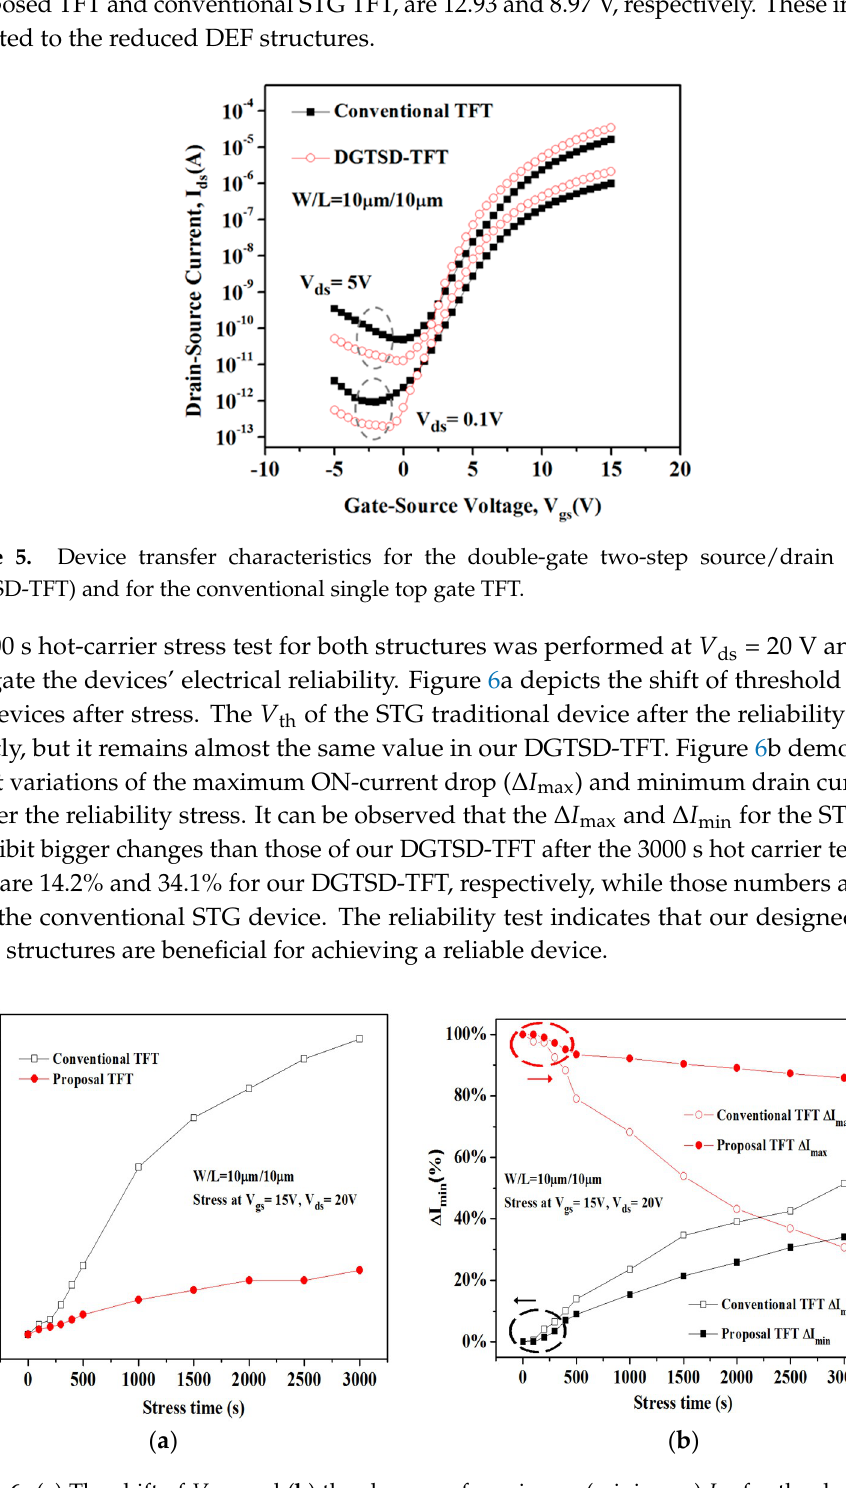
Figure 6. ( a ) The shift of V th s and ( b ) the changes of maximum (minimum) I ds for the double-gate two-step source/drain (DGTSD) TFT and conventional one versus the hot carrier stress time.